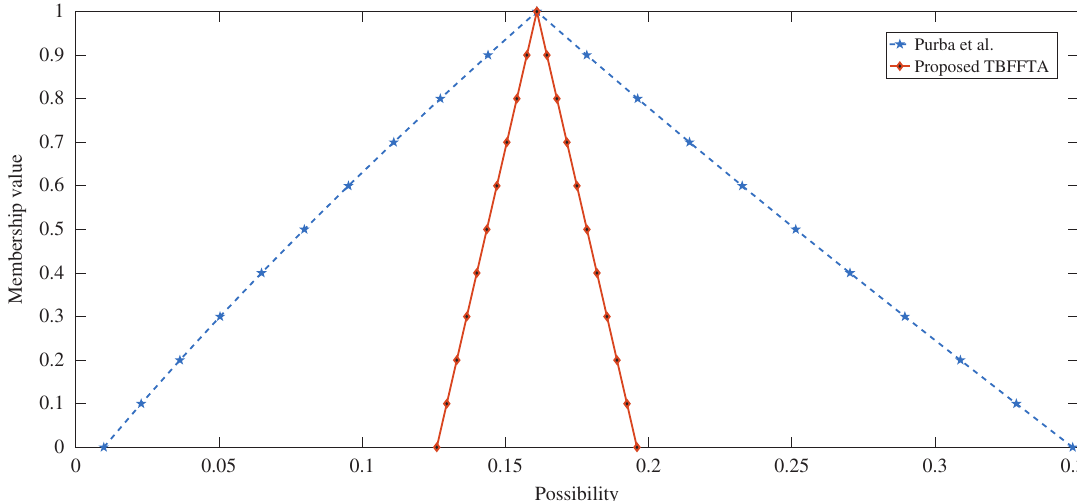
Figure 2: The Lower Bound Fuzzy Possibility of the Top Event.